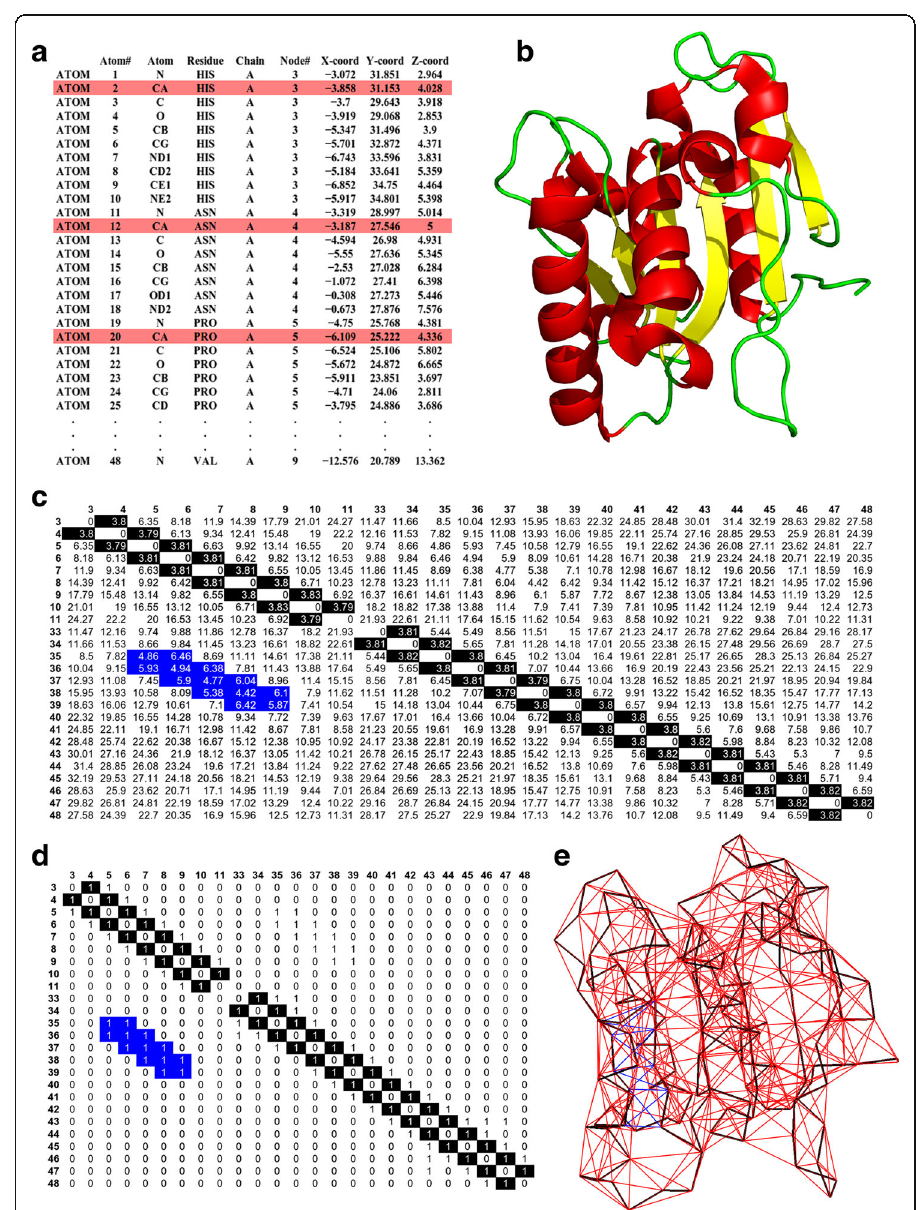
Fig. 1 Construction of the Protein Contact Network of Lipase A. ( a ) Crystallographic coordinates of all atoms of the first 3 amino acids in the protein chain. ( b ) Three dimensional structure of WT Lipase A corresponding to the coordinates; ( c ) Pair-wise Distance matrix between portion of the C- α atoms; ( d ) Corre- sponding Adjacency matrix; ( e ) PCN of WT Lipase A shown in ( b ). See text for